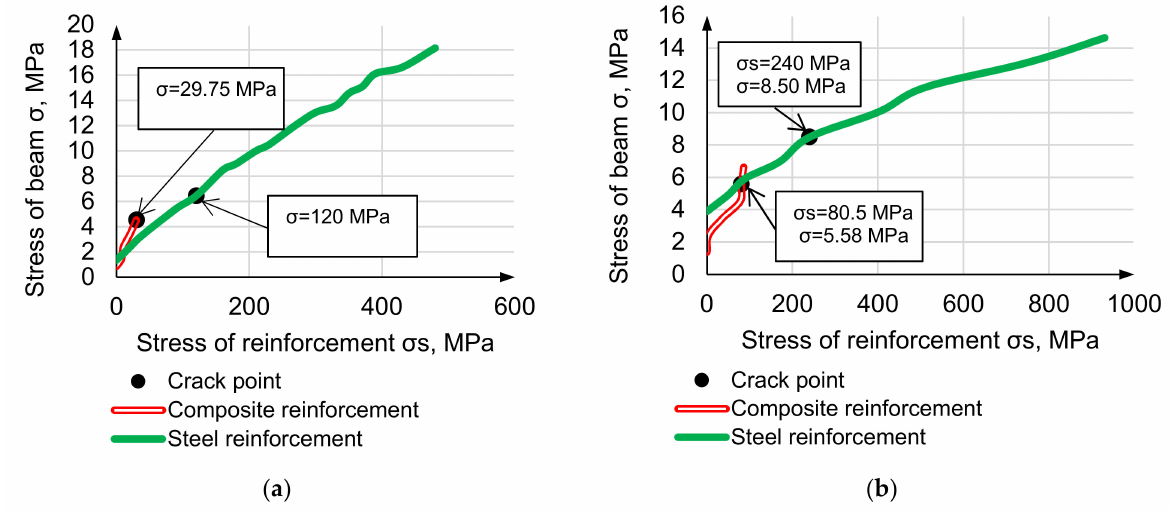
Figure 13. Beam stress-reinforcement stress curves of HWC, reinforced be steel ( a ) and composite ( b ).